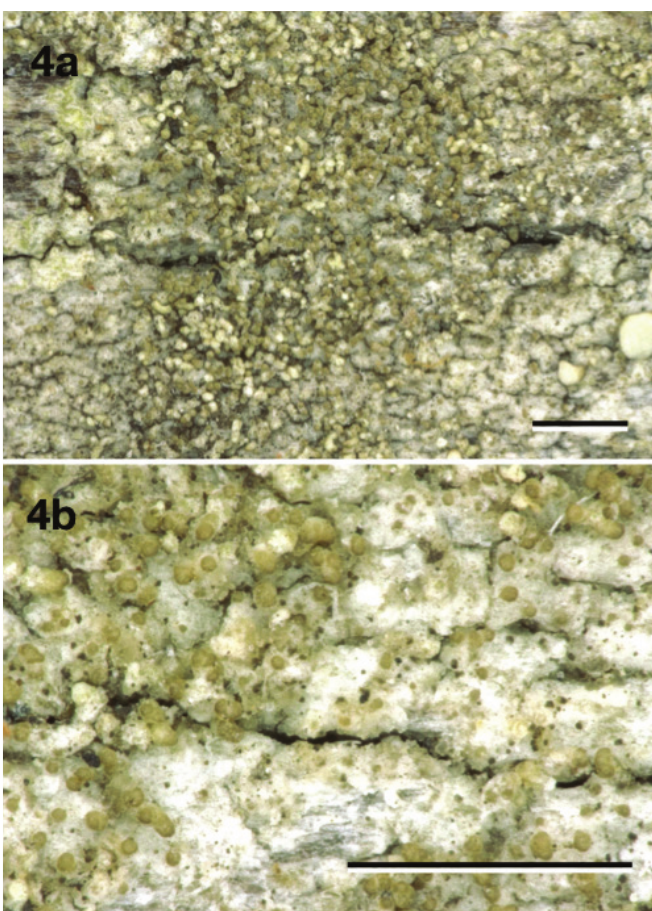
Figure 4. Neoprotoparmelia amerisidiata , holotype Lendemer 20995 (NY). Scale bar: 1 mm.